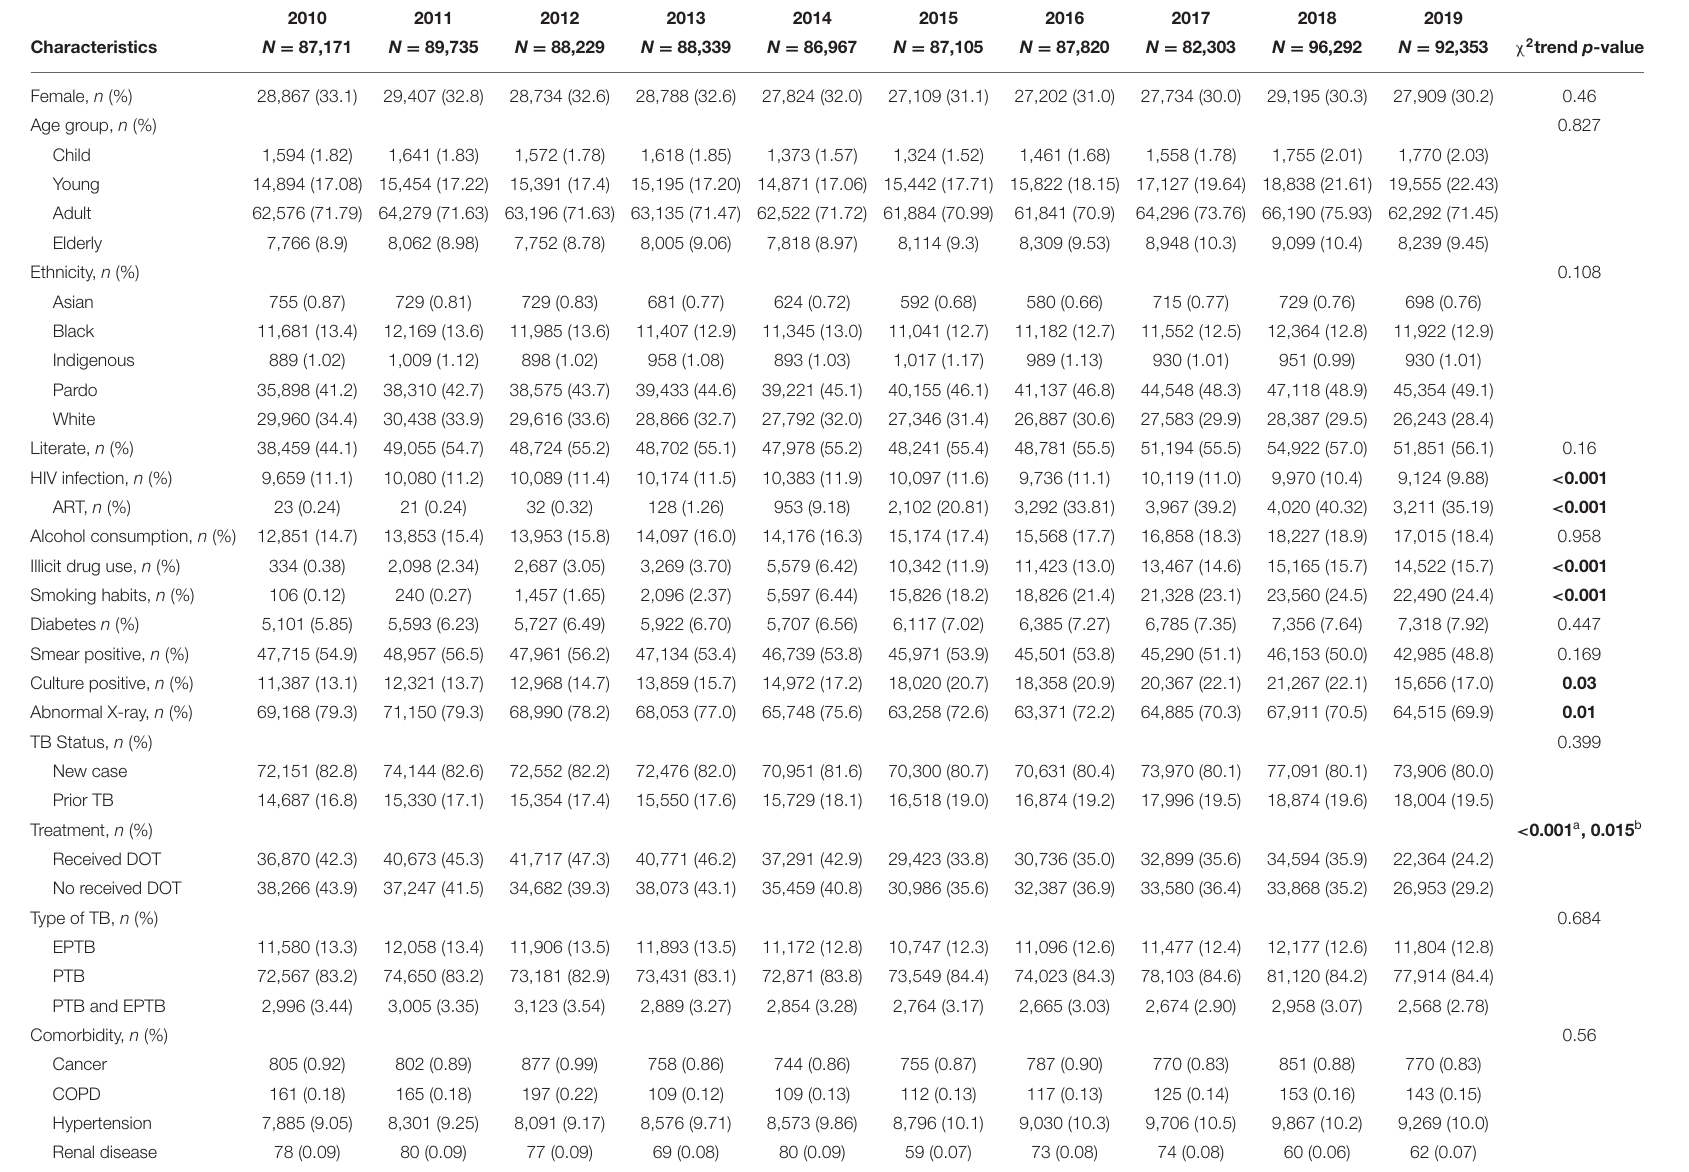
TABLE 1 | Population characteristics by